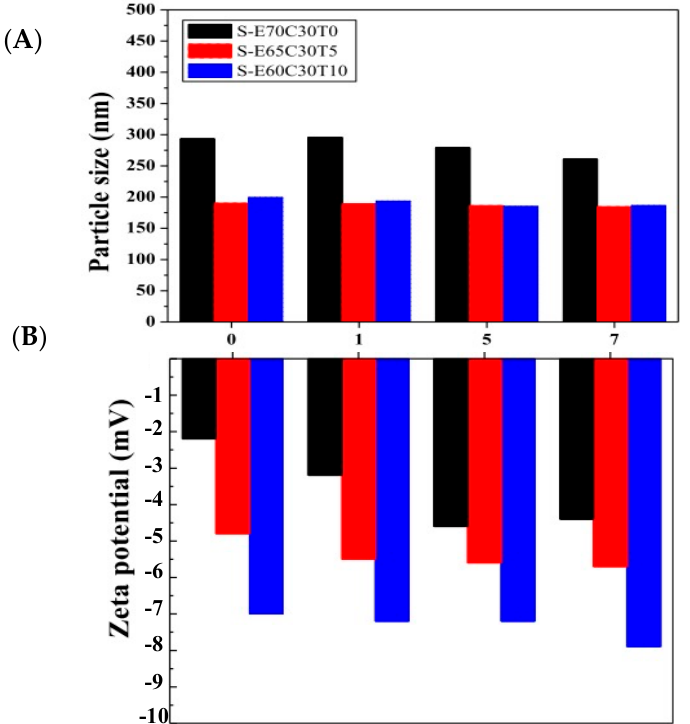
Figure 4. The stability of particle size and zeta potential of liposomal puerarin for a storage period of seven days. ( A ) the average particle size, ( B ) zeta potential.